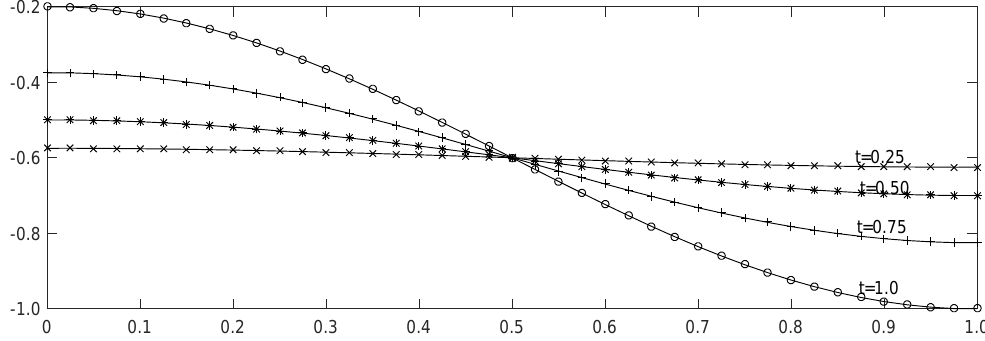
Fig. 2 A comparison of the analytic and approximate solutions using the Crank-Nicolson method for ν = 1 . 0, ∆ x = 0 . 025, γ = 0 . 5 and ∆ t = 0 . 0025 at different values of final